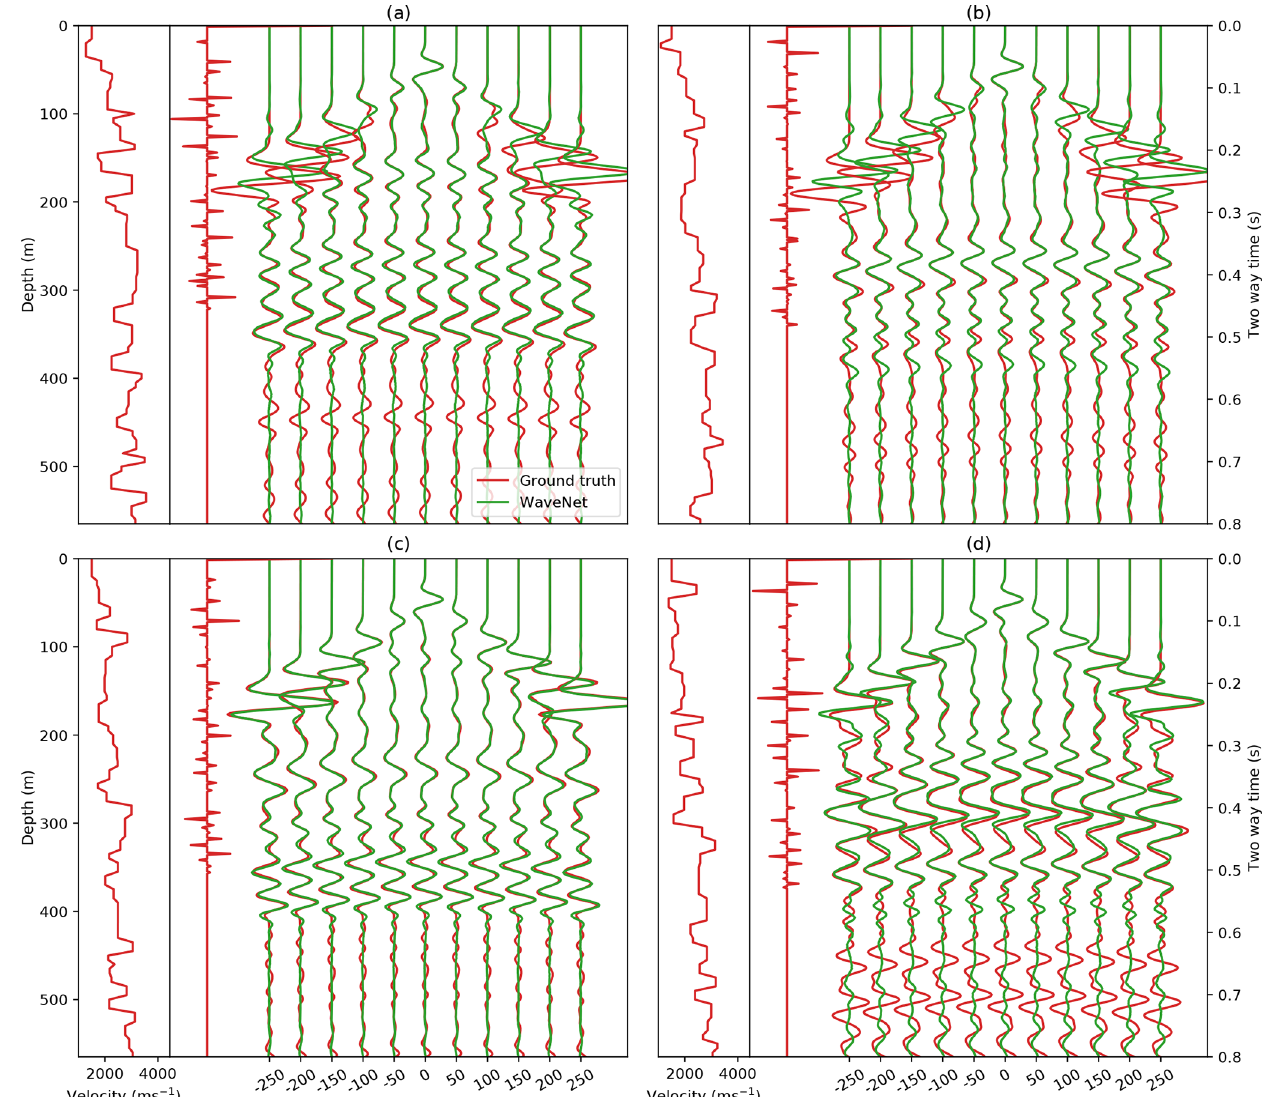
Figure 6. Generalisation ability of the WaveNet. The WaveNet simulations (green) for four velocity models with much smaller average layer thicknesses than the training distribution are compared to ground truth FD simulation. Red shows the input velocity model, its corresponding reflectivity series and the ground truth pressure responses from FD